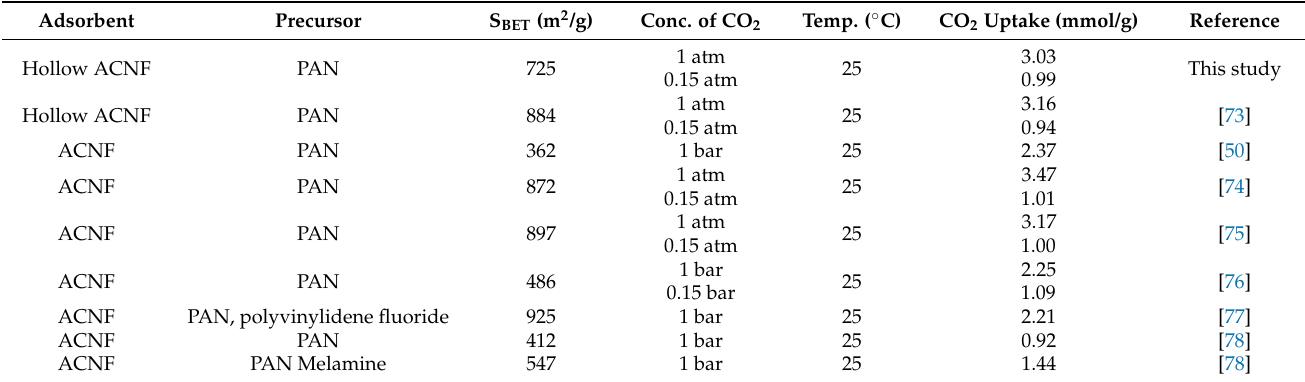
Table 7. Comparisons of CO 2 uptakes on the adsorbents in this study with various support materials using electrospinning in the